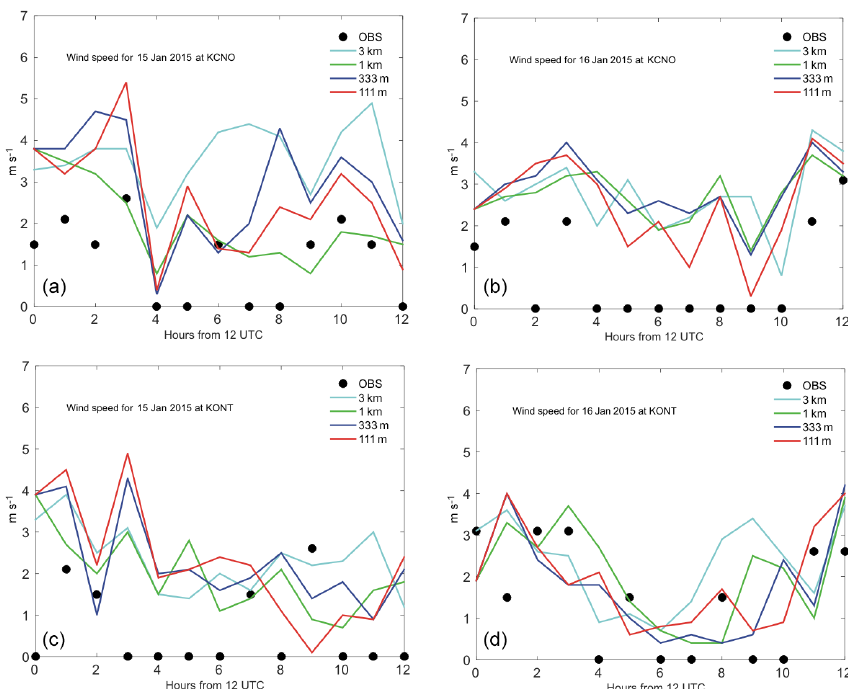
Figure 7. Mean horizontal 10m wind velocity in ms − 1 measured at Chino (KCNO) and Ontario (KONT) airports for 15 and 16 January (black circles) compared to the simulated wind speed for different resolutions using WRF hourly averaged results. When black circles indicate zero, the wind velocity measurements are below the WMO minimum threshold (i.e., 1.5ms − 1